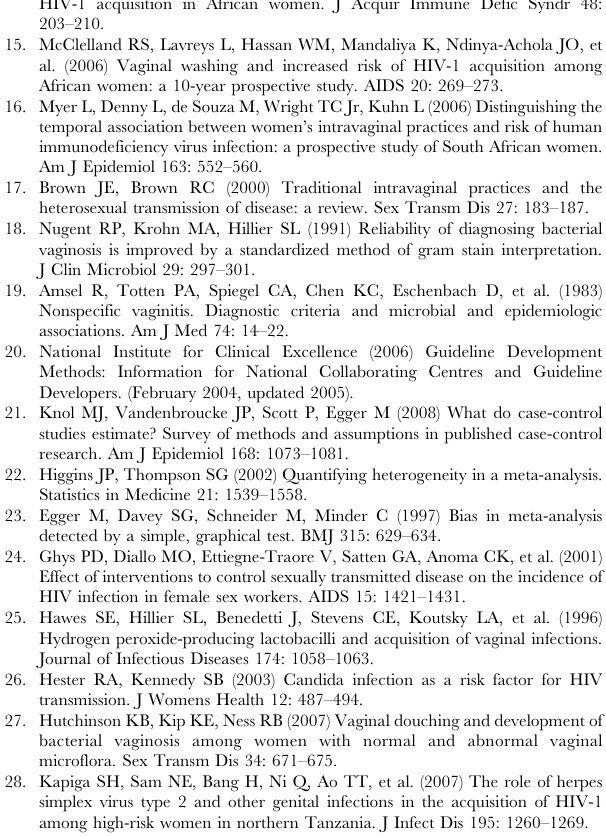
Table S1 Assessment of reporting of features related to the risk of bias. *** criterion well-covered; ** criterion adequately